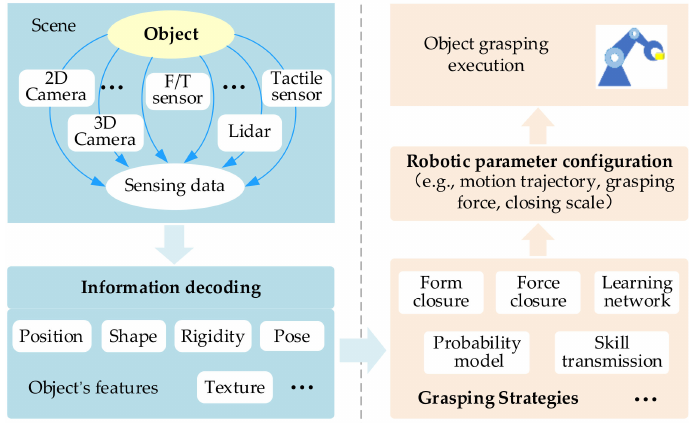
Figure 1. Pipeline describing feature sensing and robotic